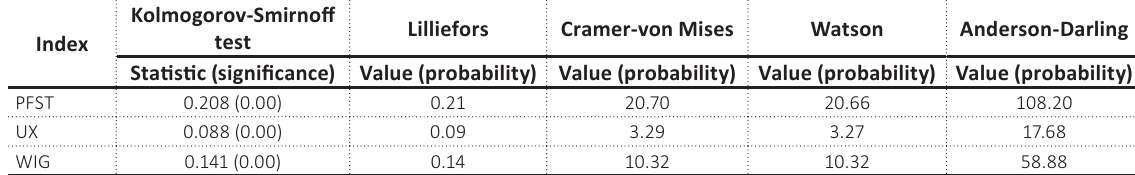
Table 4. Normality tests for ESG and conventional indices (case of returns)